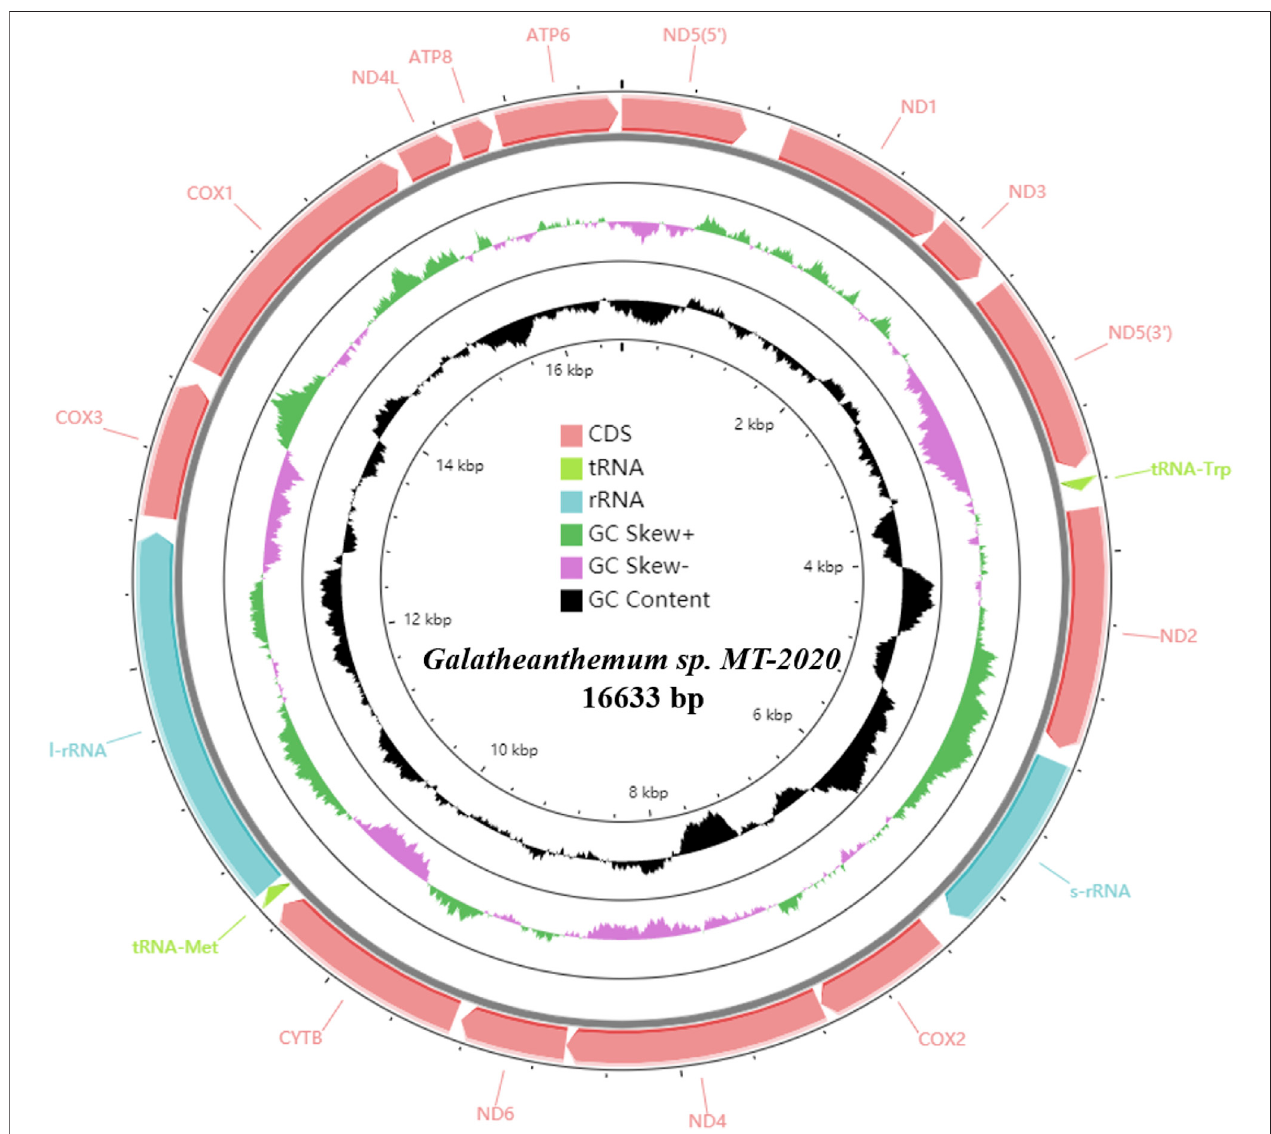
FIGURE 1 | Circular map of the mitogenome of Galatheanthemum sp. MT-2020. All of the genes were encoded on the heavy strand.